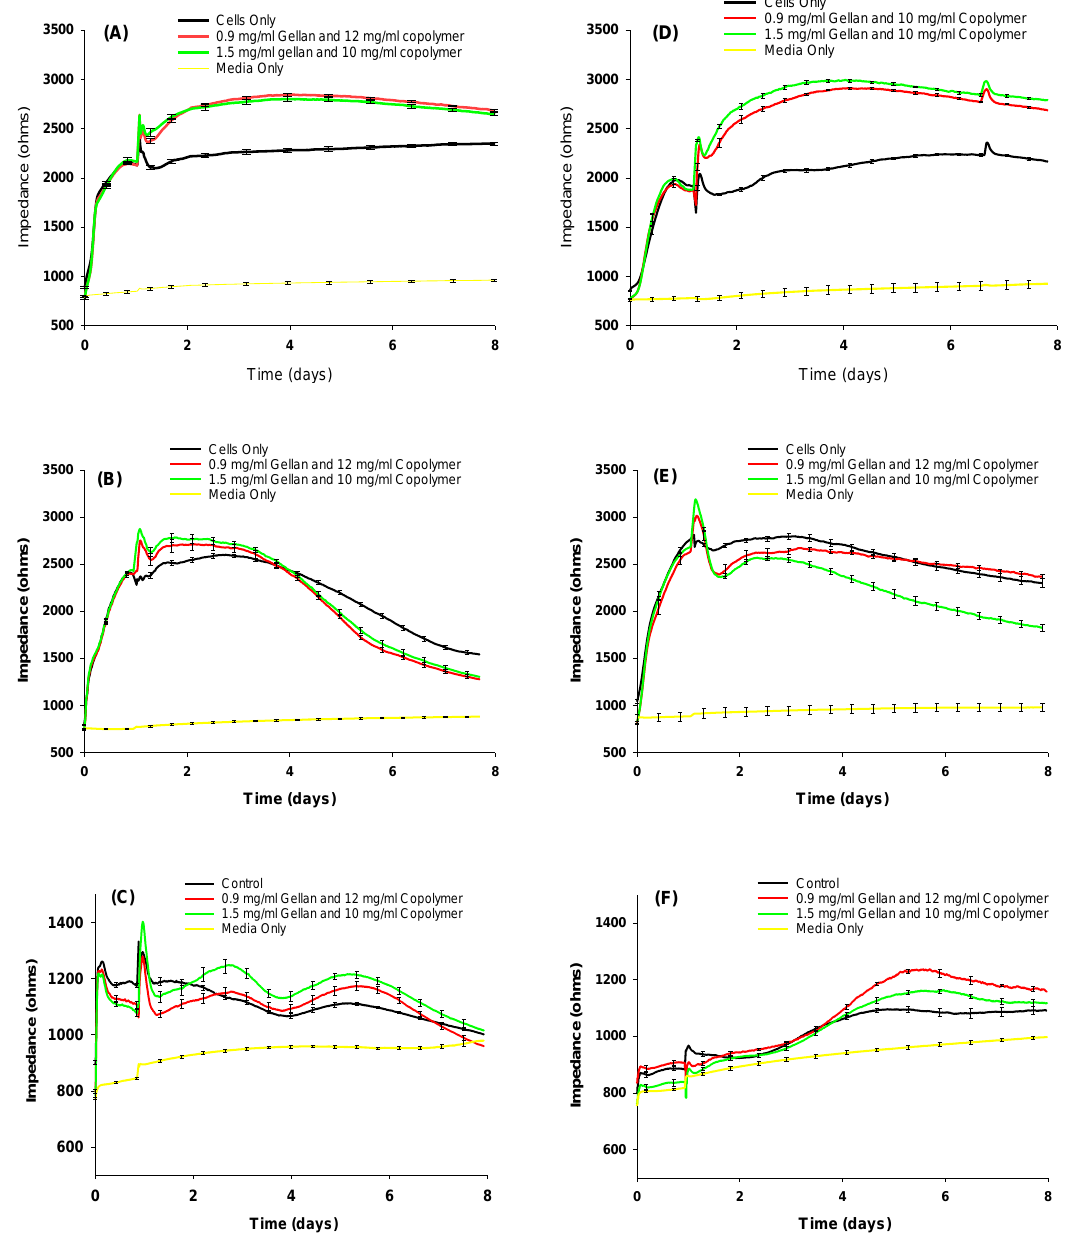
Figure 3. Resistance measurements with the two hydrogel formulations of confluent ( A ) APRE-19, ( B ) ppRPE, ( C ) 3T3 cells; and proliferating ( D ) ARPE-19, ( E ) ppRPE, and ( F ) 3T3/NIH cells. Values are given in mean ± SEM (n = 4).